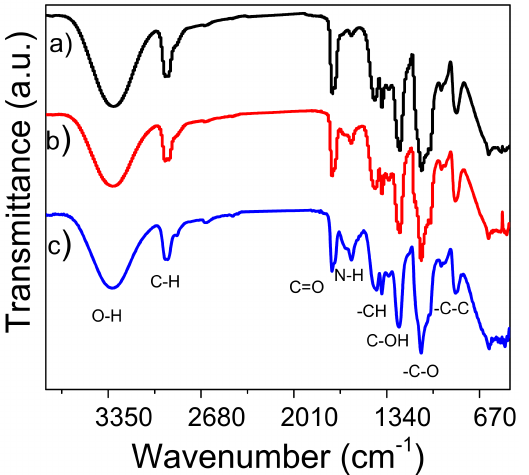
Figure 2. FT-IR spectra of nanofibers (a) PVA, (b) PVA/ γ -PGA 5 and (c) PVA/ γ -PGA